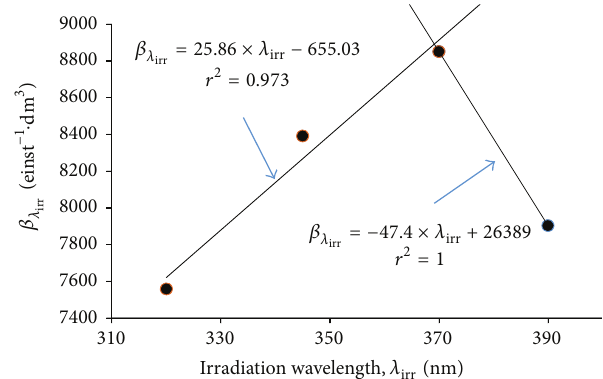
factors with irradiation wavelengths irr